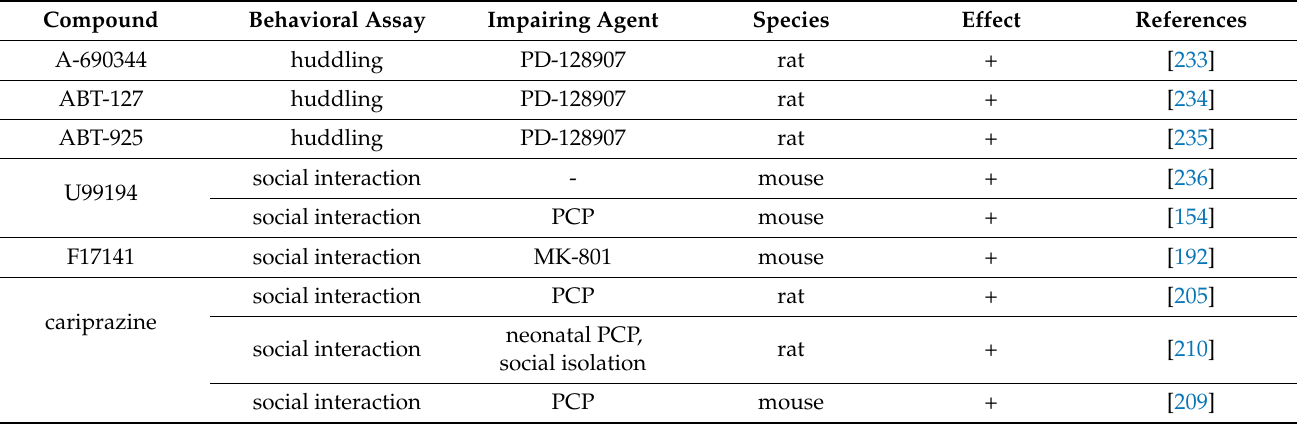
Table 6. Social behavioral effects of D3